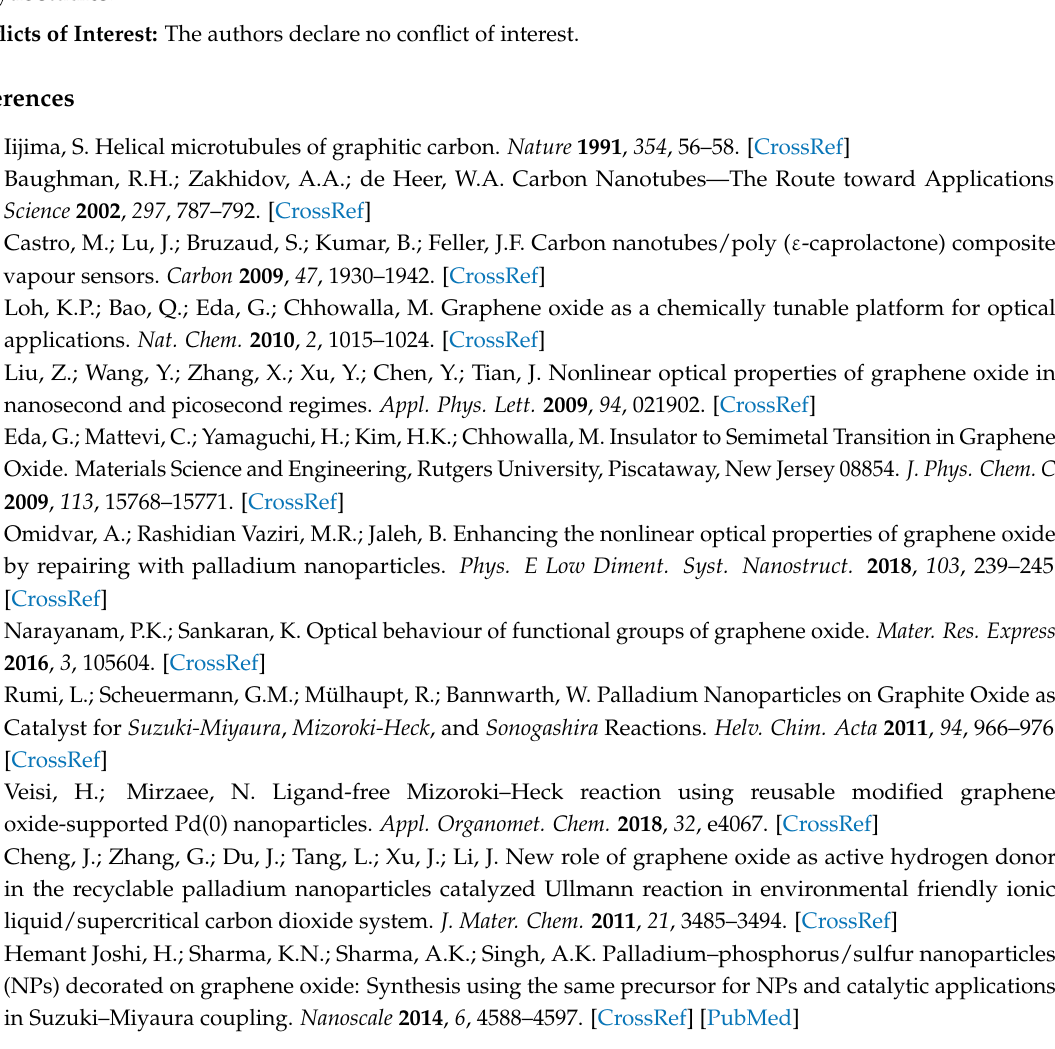
Figure S1: Emission spectra of Pd/GO and Pd/GO-TiO 2 at λ ex = 445